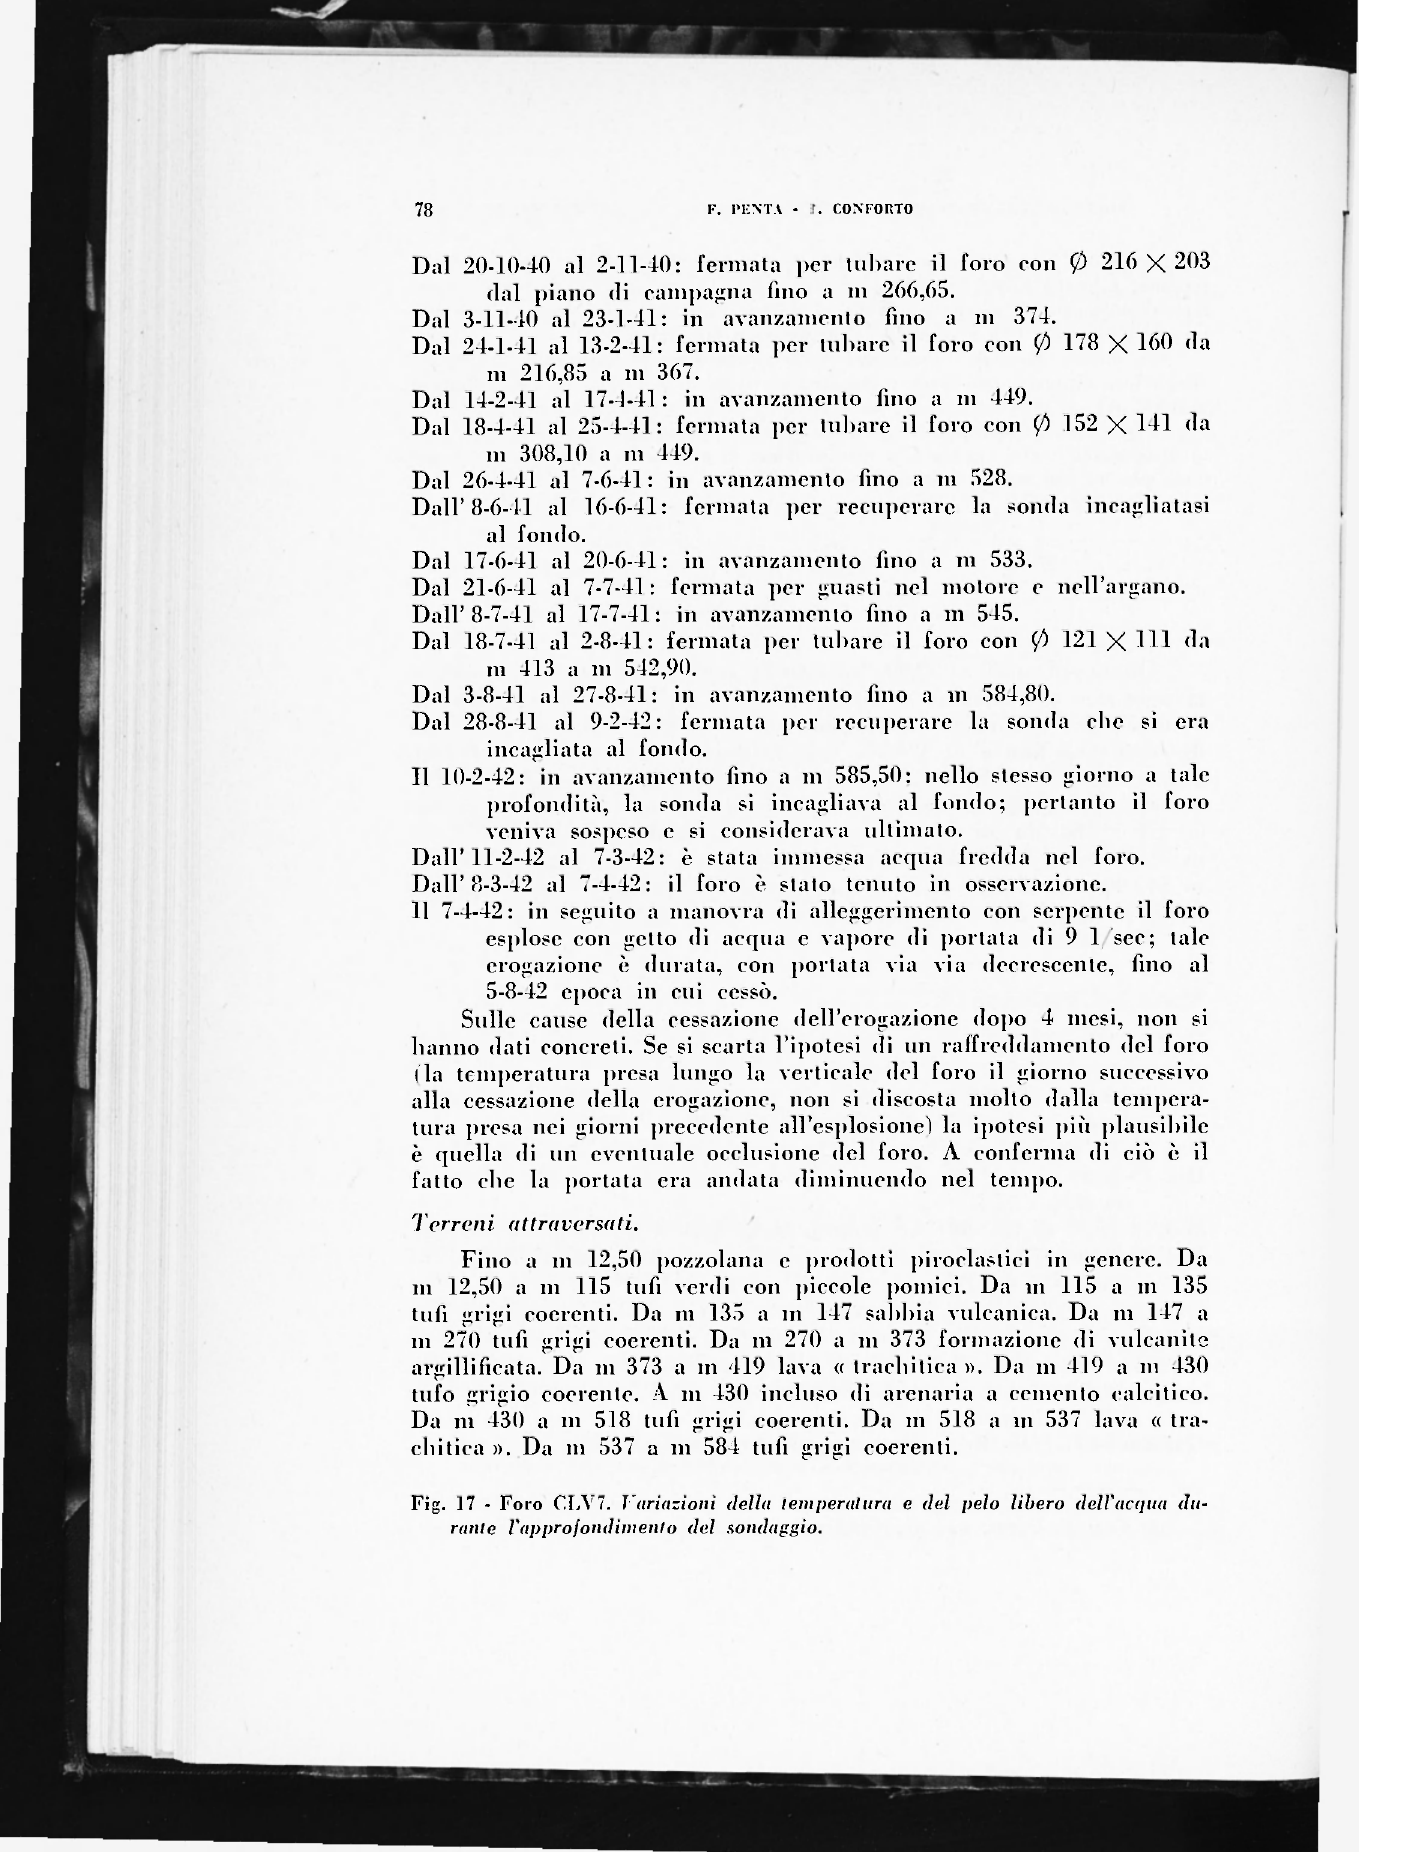
Fig. 17 - Foro CIA 7. Variazioni delta temperatura e del pelo libero dell'acqua du- rante l'approfondimento del